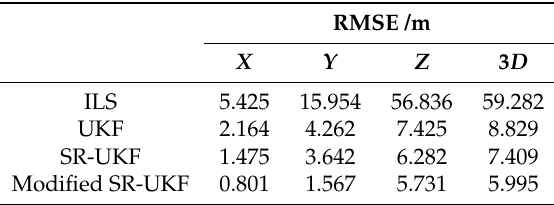
Figure 8. Estimation error using BDS/GPS’s Data after removal. Table 6. Positioning estimation error using BDS/GPS’s data after